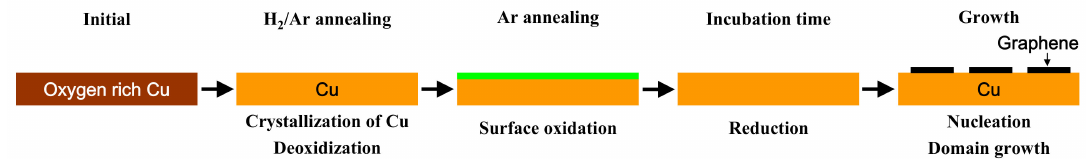
Figure 8. Schematic illustration of the evolution of the Cu surface during the CVD. The initial, H 2 /Ar annealing, Ar annealing, and incubation time correspond to the CVD process at #1–4 in Figure 1b,